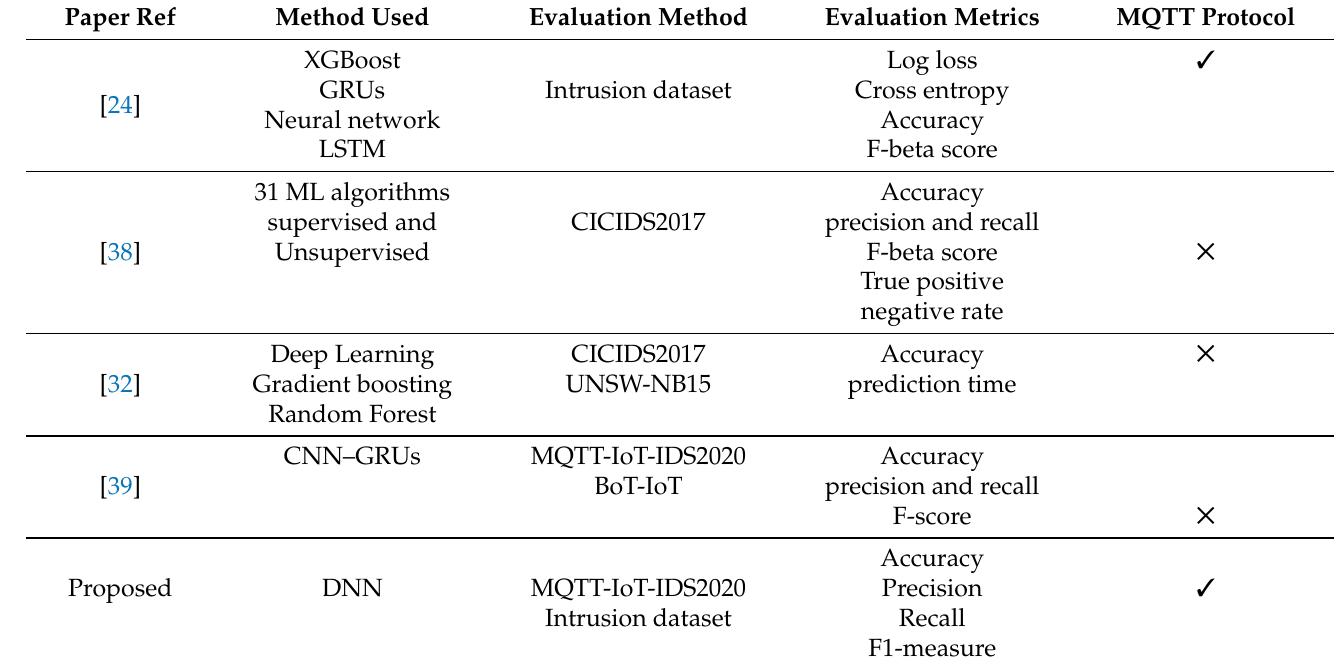
Table 2. Review of Intrusion detection systems for MQTT